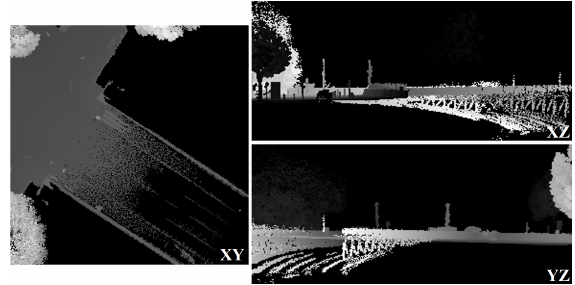
Figure 9. The three images produced from the point cloud set of Figure 1a illustrating depth